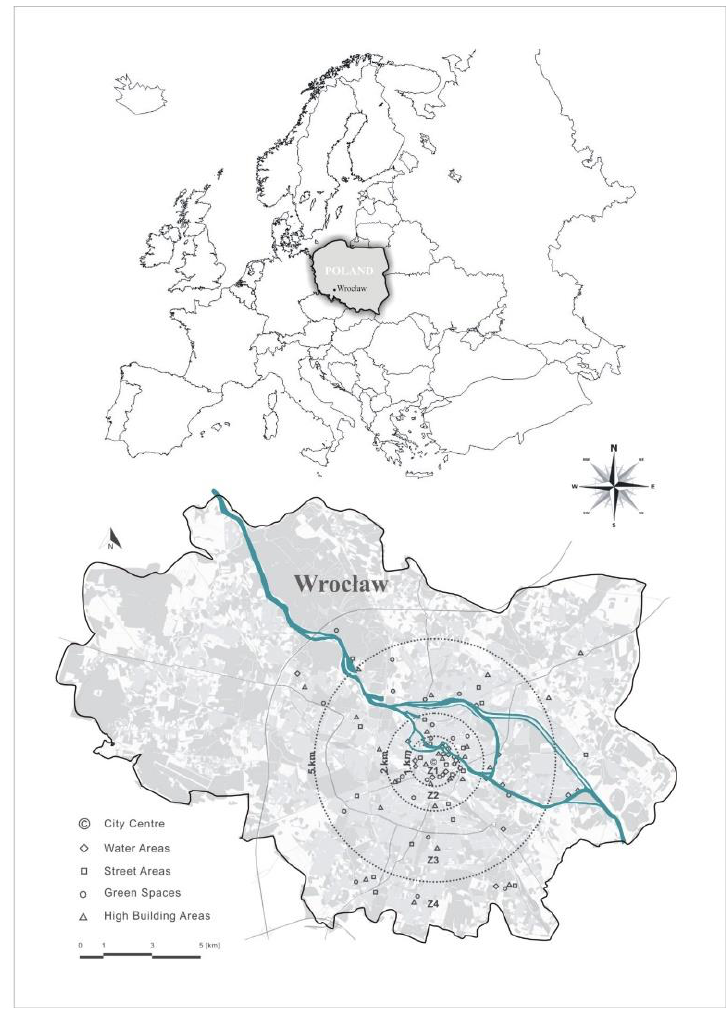
Figure 1. Localization of the research area and distribution of research facilities in Wrocław.